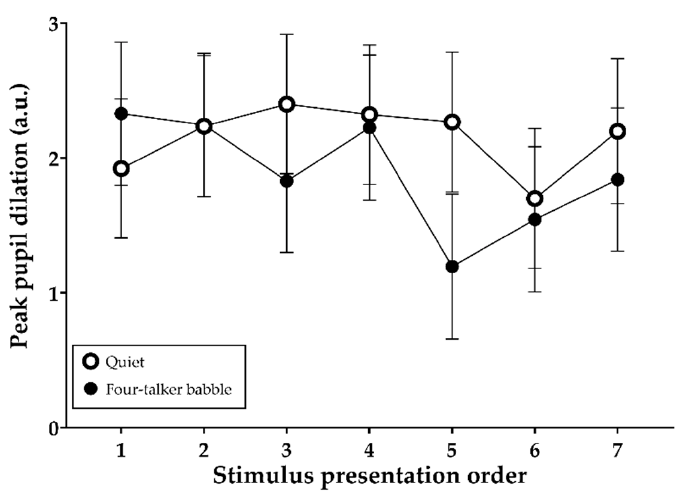
Figure 6. Mean and 95% confidence intervals of peak pupil dilations in the quiet and four-talker babble conditions as a function of stimulus presentation order.